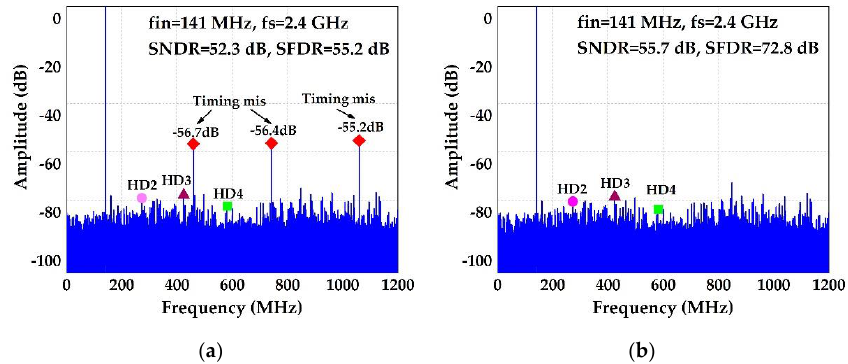
Figure 13. Measured output spectrum when fin = 141 MHz ( a ) before timing mismatch calibration and ( b ) after timing mismatch calibration.